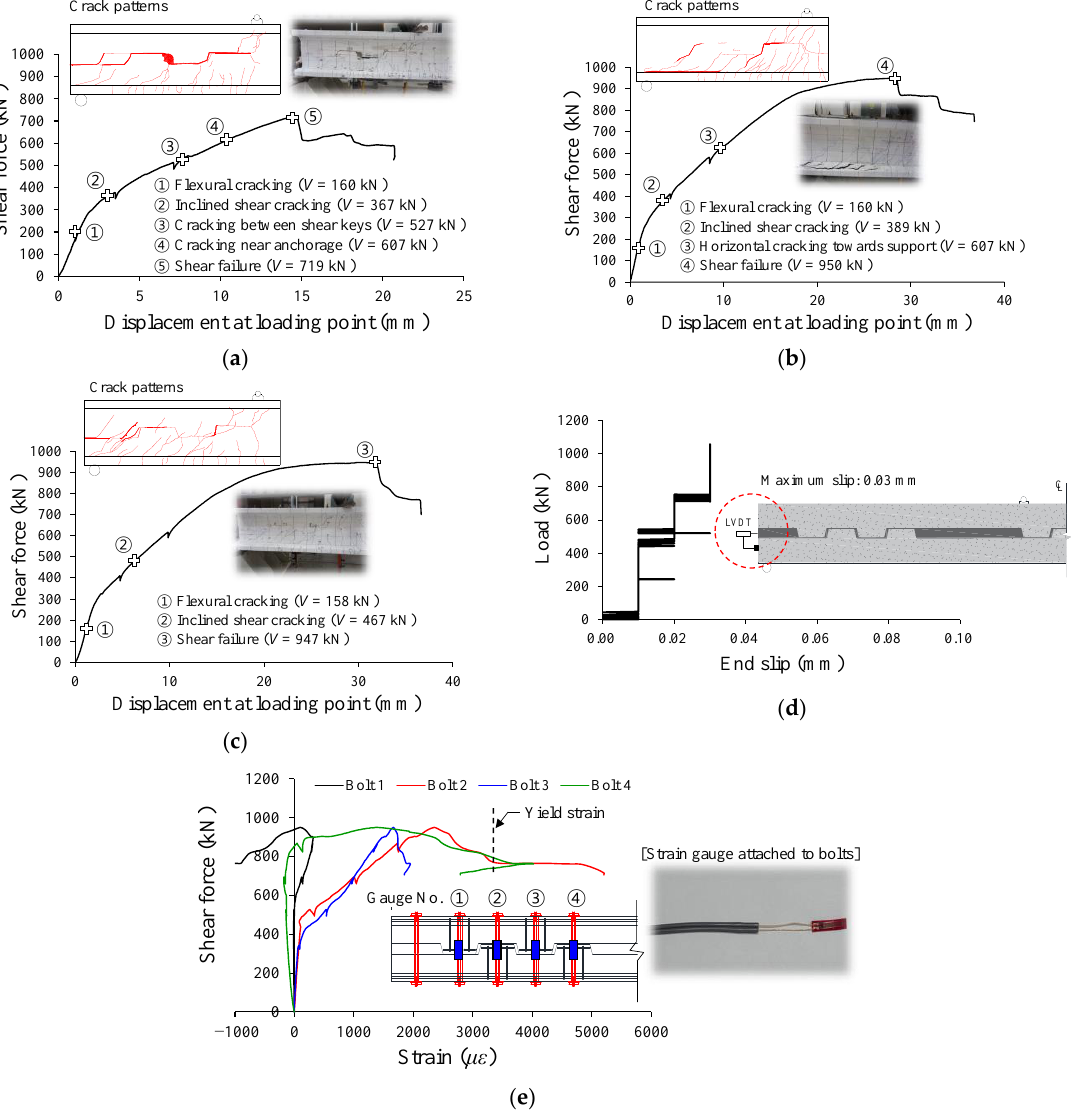
Figure 7. Shear behavior of the DCW-S specimen series: ( a ) DCW-SN specimen; ( b ) DCW-SB(1) specimen; ( c ) DCW-SB(2) specimen; ( d ) measured end slip (DCW-SN specimen); ( e ) measured bolt strains (DCW-SB(1) specimen).